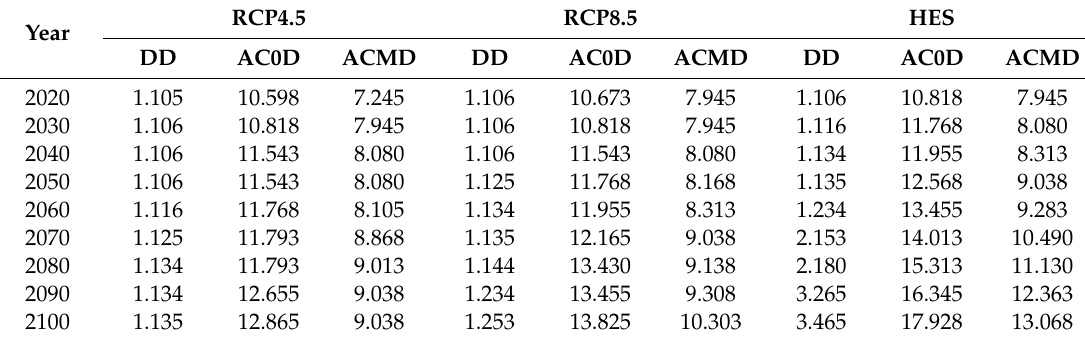
Table 3. Damage and adaptation costs (in M € ) for TR = 50 years. DD: Direct damages; AC0D: adaptation costs with 0 damage; ACMD: adaptation costs with minimum